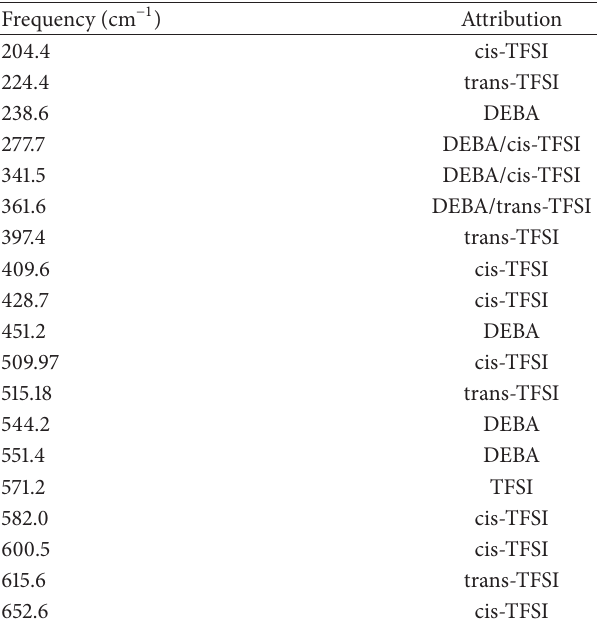
Table 4: Experimental vibration frequencies at 160K and attribu- tion to